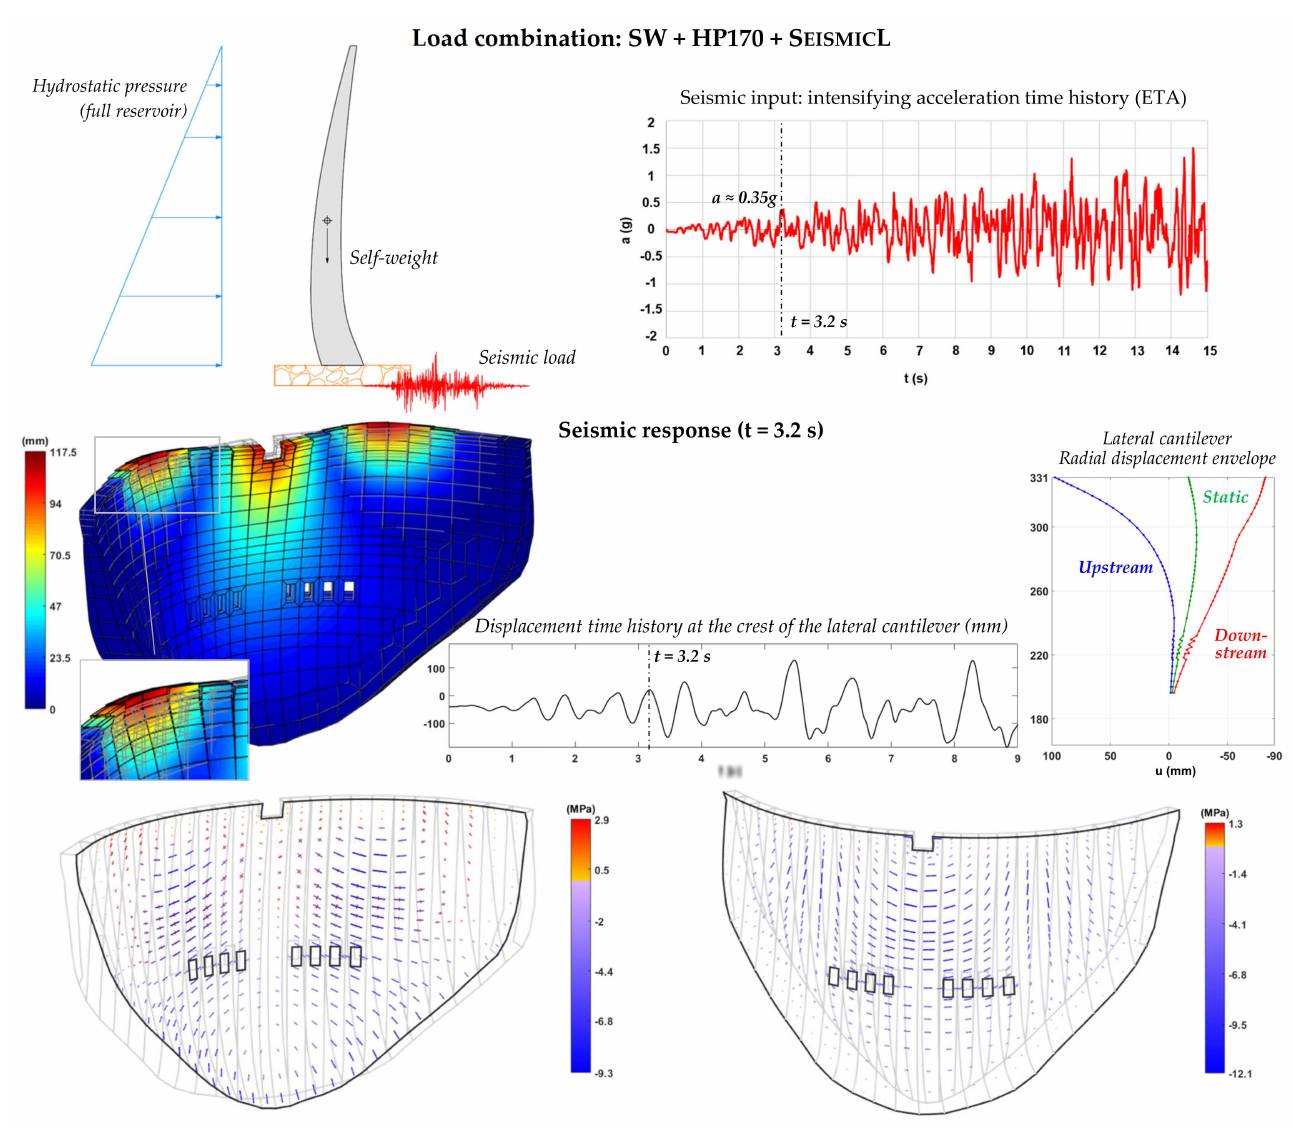
Figure 13. Non-linear seismic analysis of Cahora Bassa Dam. Deformed shape and principal stresses for t = 3.2 s, radial displacement envelope for the lateral cantilever (until t = 3.2 s), and displacement time history at the crest of the lateral